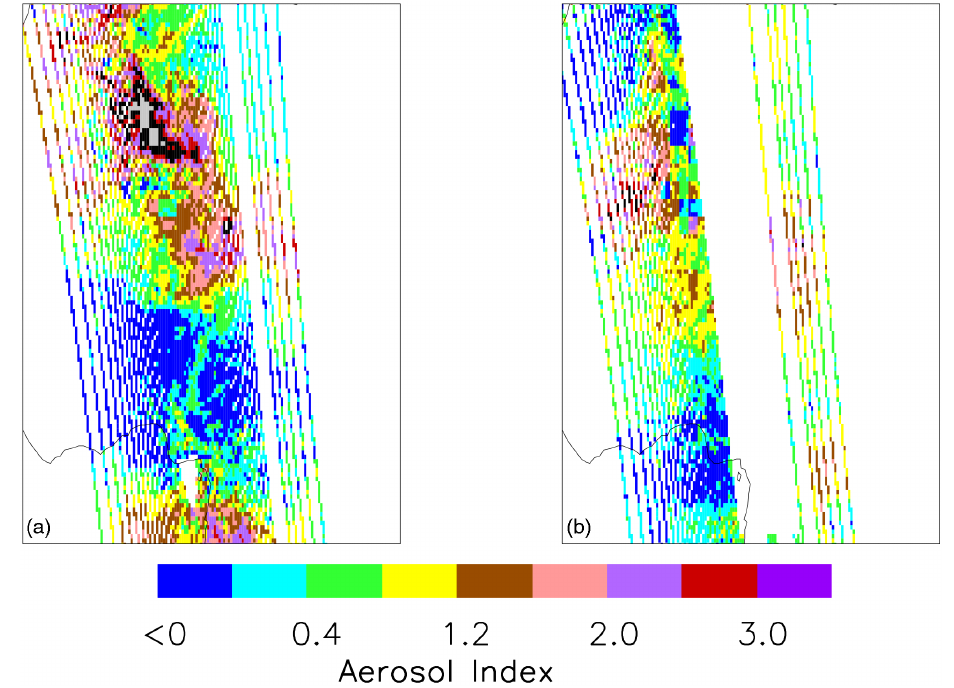
Figure 11. (a) A single swath from OMI over northern Africa on August 1 2007 before the significant data loss reported in all OMI aerosol products. (b) A single OMI AI swath over the same region as (a) on 1 June 2009 which is affected by the significant data